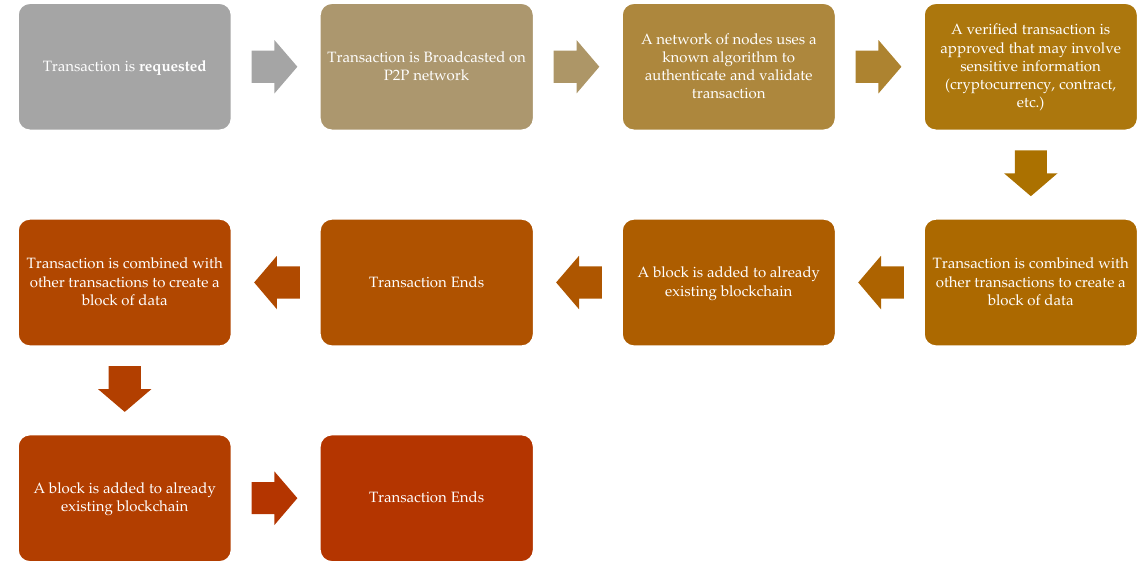
Figure 5. Blockchain Working.